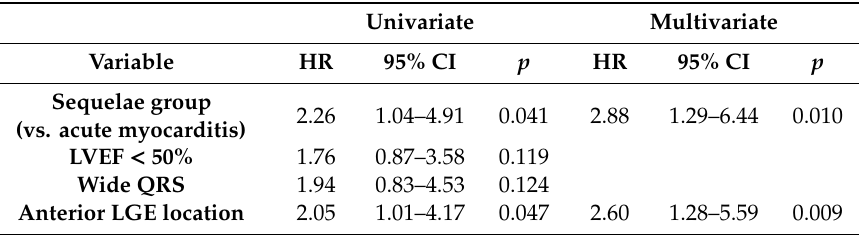
Table 7. Univariate and multivariate backward stepwise Cox regression analysis to estimate predictors of major arrhythmic ventricular events in the total ICD population ( n = 61 after exclusion of 7 missing data patients).